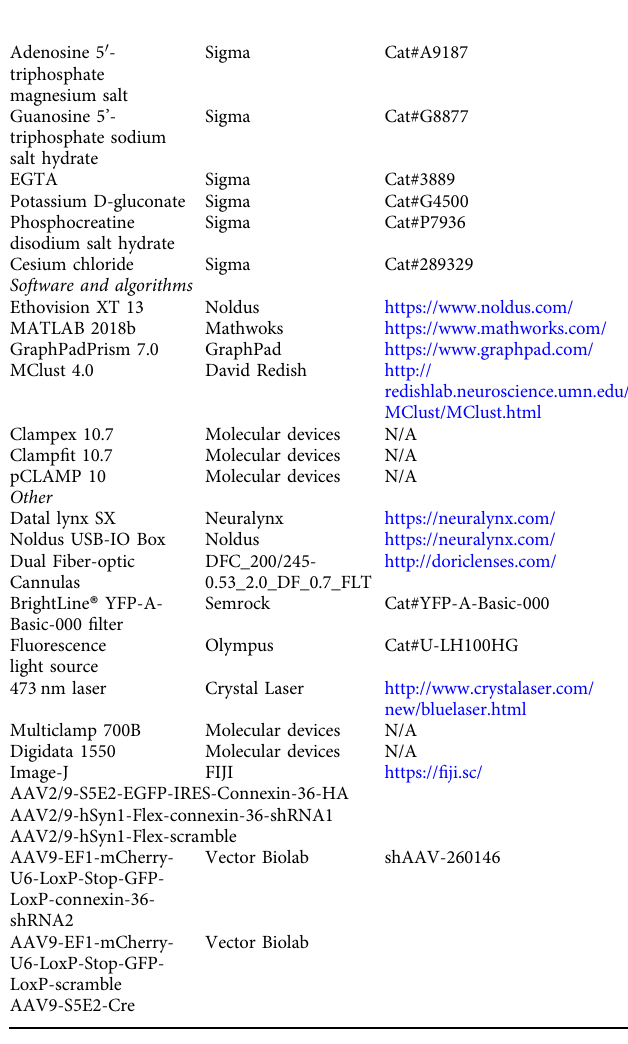
Fig. 9 Pv neuronal bursts suppress cortical spike-wave synchrony in the Shank2 – / – mPFC, and Pv neuronal gap junctional inhibition moderately enhances social interaction in WT mice. a Examples of spike-wave synchrony. Low-gamma oscillations extracted from raw LFPs were aligned with individual spikes to determine spike-wave synchrony. Arrows (blue), snif fi ng (nose-poke) onset for social target; rose plots, polar histograms of phase synchrony of a representative neuron during social interaction; red-colored bars, the sum of individual vectors. b Comparisons of spike-wave synchronies for the social target across different frequency ranges in the WT and Shank2 – / – mPFC in the presence of Pv neuronal stimulation during social interactions. Data: minimal, maximal, median, 25%, and 75% values ( n = 224 neurons from 7 mice for WT-EYFP, 91/8 [WT-ChR2], 145/4 [KO-EYFP], and 331/9 [KO- ChR2], ** p < 0.01, *** p < 0.001, two-way ANOVA with Tukey ’ s test; interaction p = 0.0003, genotype p = 0.17, virus p = 0.7 [theta], interaction p < 0.0001, genotype p = 0.096, virus p = 0.939 [alpha], interaction p < 0.0001, genotype p = 0.096, virus p = 0.939 [low-gamma], interaction p < 0.0001, genotype p = 0.001, virus p = 0.025 [high-gamma]). c Direct me fl oquine infusion (25 μ M) into the mPFC of WT and Shank2 – / – mice does not affect three-chamber social interaction, as shown by snif fi ng time for social/object targets and the social preference index ([social-snif fi ng time − object- snif fi ng time]/total snif fi ng time%). Data: minimal, maximal, median, 25%, and 75% values ( n = 11 mice [T-Veh/vehicle] 11 [WT-MQ/me fl oquine], 8 [KO- Veh], and 8 [KO-MQ], two-way RM-ANOVA). d Connexin-36 knockdown in Pv neurons in the mPFC of WT mice, using two independent shRNA constructs, moderately increases three-chamber social interaction. AAV-S5E2-Cre + AAV- fl ex-shRNA1/2-EGFP (or scrambled shRNA control) were injected into the WT mPFC at 14 – 16 [shRNA1] and 8 – 10 [shRNA2] weeks, followed by social-interaction tests after 2 weeks. Data: minimal, maximal, median, 25%, and 75% values ( n = 8 [WT-control_1], 8 [WT-shRNA1], 9 [KO-control_1], and 9 [KO-shRNA1], 10 [WT-control_2], 10 [WT-shRNA2], 10 [KO-control_2], and 10 [KO-shRNA2], * p < 0.05, ns, not signi fi cant, two-way RM-ANOVA, two-tailed Mann – Whitney test, and two-tailed Student ’ s t -test; interaction p = 0.2335, treatment p = 0.3617, target p < 0.0001 [snif fi ng-shRNA1], p = 0.0274 [preference-shRNA1], interaction p = 0.1258, treatment p